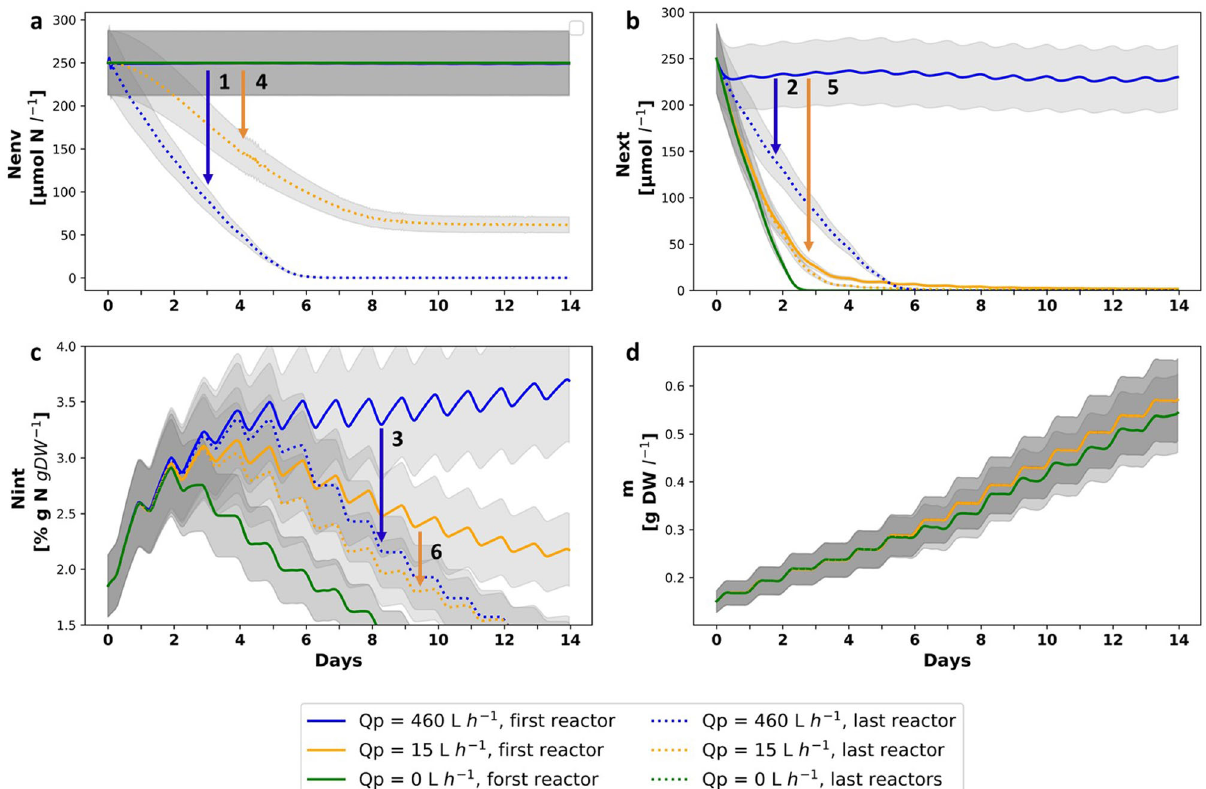
Fig. 5 N env , N ext , N int and m dynamics along a 14 days cultivation period, simulating Q p values of 0, 15, and 460 l h − 1 . Arrows highlight differences between fi rst and last reactor: a N env dynamics: differences for Q p = 460 l h − 1 and for Q p = 15 l hour − 1 are marked by (1) and (4), b N ext dynamics: differences for Q p = 460 l h − 1 and for Q p = 15 l hour − 1 are marked by (2) and (5), c N int dynamics: differences for Q p = 460 l hour − 1 and for Q p = 15 l hour − 1 are marked by (3) and (6), and d m dynamics. Simulation parameters and IC: 731 reactors, spring season, N env 0 = 250 μ M-N, d = 0. Shaded region represents a 15% calibration error.